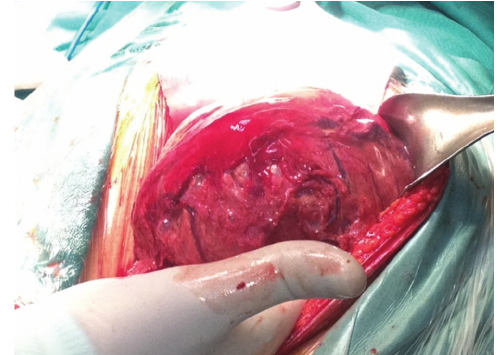
Figure 2: Twisted stomach (gastric volvulus).